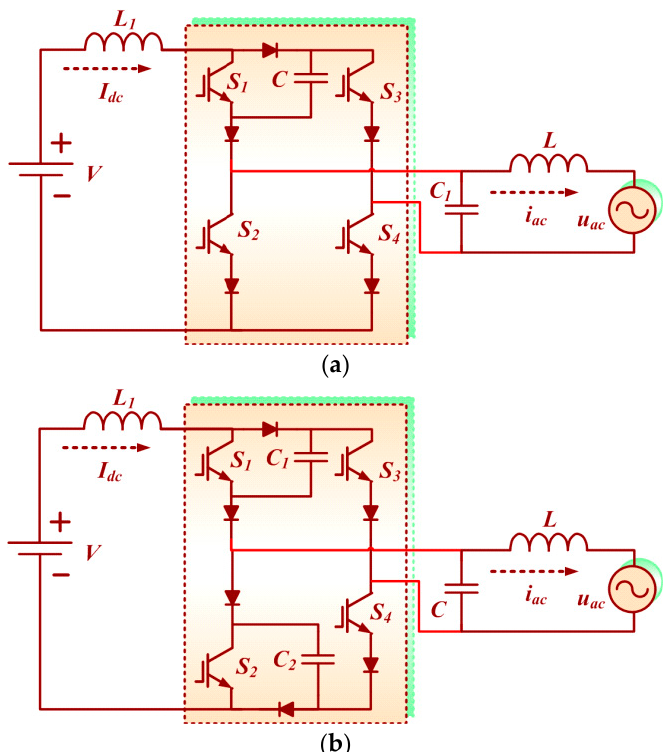
Figure 14. Power decoupling solution with no auxiliary switch [41,42]. (a) 1-capacitor configuration; ( b ) 2-capacitor configuration.